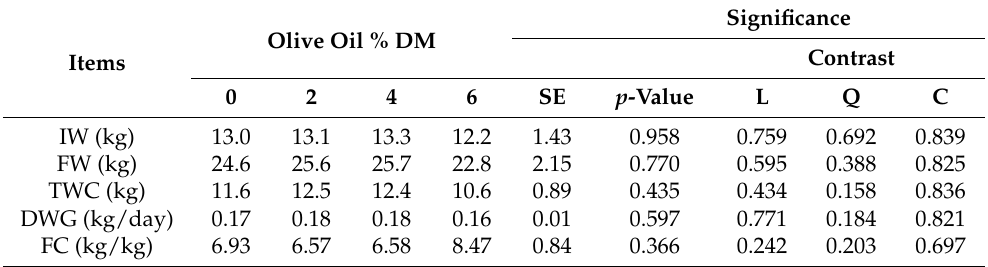
Table 6. Production performance in lambs fed with different levels of olive